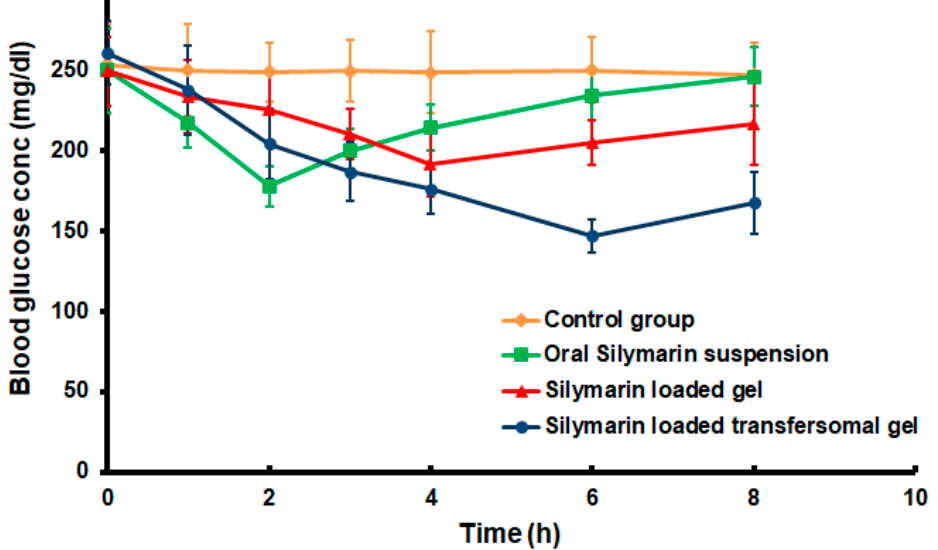
Figure 8. Blood glucose concentration after administration of different Silymarin formulations. Data represented as mean ± SD ( n = 5).